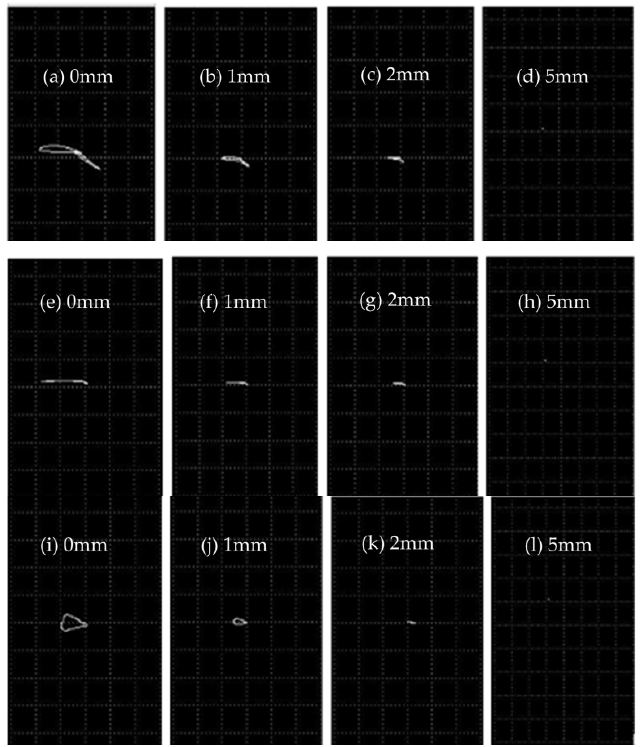
Figure 9. Impedance diagram of three types of cracks retrieved under different lift-offs: weld crack ( a – d ) body crack ( e – h ) and weld toe crack ( i – l ).